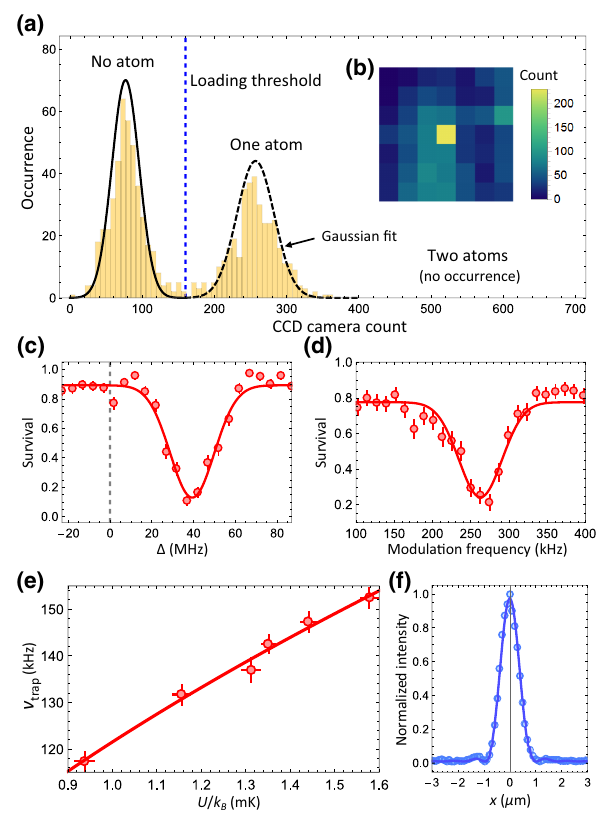
FIG. 2. Single-atom trapping in a metalens optical tweezer. (a) A camera-count histogram indicating the presence of either zero or one atoms in a tweezer trap. A threshold is chosen to determine if an atom is trapped and to calculate the loading efficiency. (b) A typical single-shot fluorescence image of a single atom imaged through the metalens with PGC imaging. (c) A typical light-shift measurement with a Gaussian fit (red line) to the shifted atomic resonance. The dashed line corresponds to the free-space 87 Rb D 2 F = 2 to F (cid:3) = 3 transition. (d) A typical parametric heating measurement with a Gaussian fit (red line) to extract the trap fre- quency ( ν trap ) from the modulation resonance (2 ν trap ). Each point is an average of 100 trap-loading sequences. (e) The measured trap frequency versus the trap depth (light shift) obtained from multiple measurements similar to (c) and (d). The solid red line is a model fit (see main text) to extract the effective Gaussian tweezer waist seen by the trapped atom. (f) The peak-normalized cross section of the intensity transmission through a 300-nm- diameter pinhole imaged at the 852-nm trapping wavelength by the metalens. The solid blue line is an Airy function fitted to the data to extract the spot size and effective NA. [The error bars in (c) and (d) represent the standard deviation and the error bars in (e) are the standard error of the fitted Gaussian